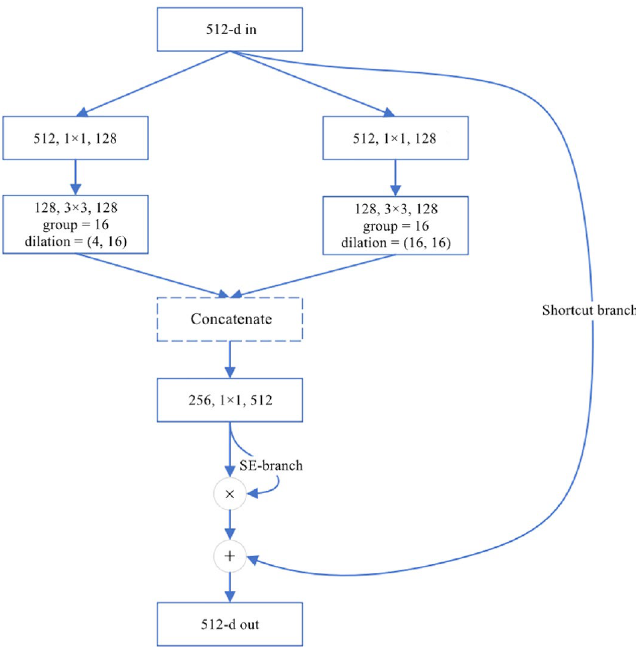
Figure 5. Illustration of the SE-ResNeXt block with dilated convolution. The original standard group convolution with 32 groups is divided into two branches with 16 groups, and the dilation rates of the dilated convolutions are (4,16) and (16,16). Finally, the results of the two branches are concatenated. A layer is denoted as (input channels, filter size, output